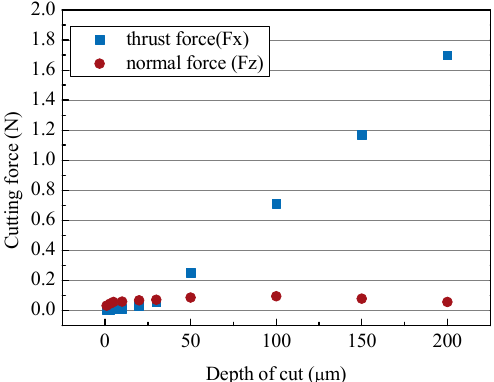
Figure 8. Cutting forces according to different depths of cut (depths of cut: 5–200 µm; feed rate: 250 µm/s; 50,000 rpm).